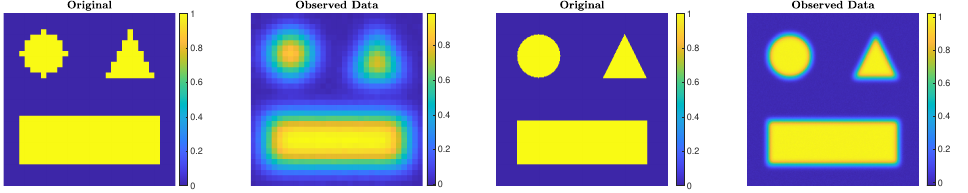
Figure 1. Experiment 1. Simple geometric pattern that has been blurred by some Gaussian blur and corrupted by some Gaussian noise. From the left, the first and second frames are for the N = 32 case, and the third and fourth frames are for the N = 256